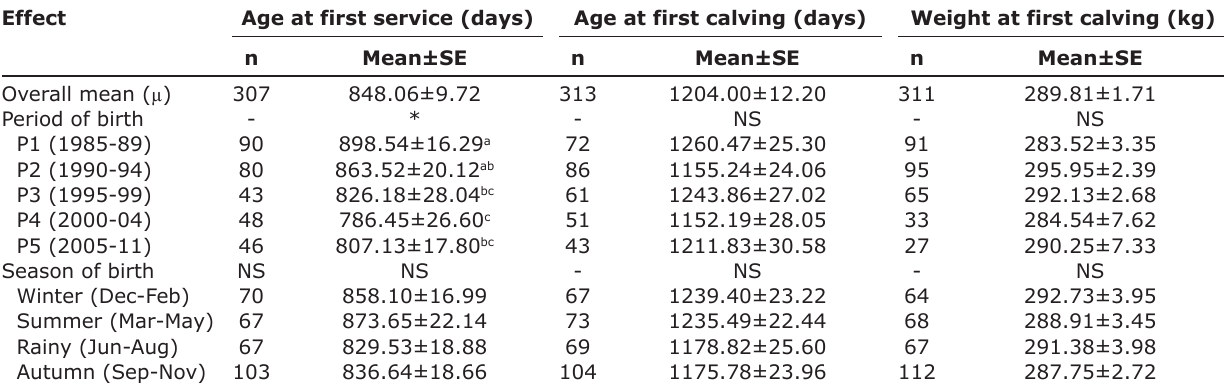
Table-2: Least-squares means (±SE) for age at first service (days), age at first calving (days), and weight at first calving (kg) in Jersey×Red Sindhi crossbred cows. Effect Age at first service (days) Age at first calving